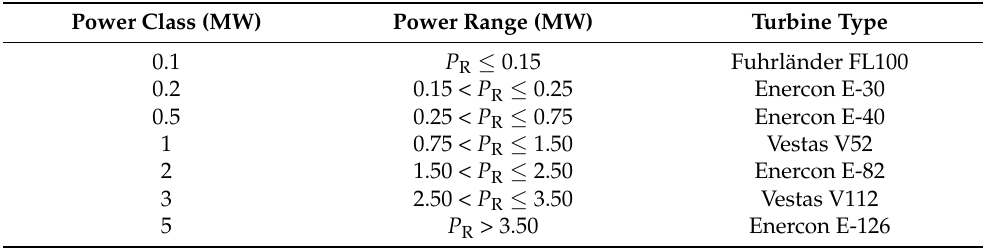
Table 2. Power classes with the corresponding ranges of rated power ( P R ) and the applied turbine types.